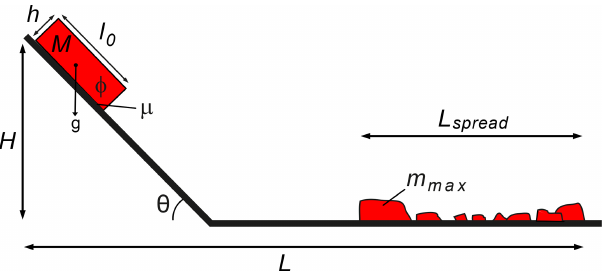
Figure 1. Sketch of the slope geometry of experiments, relevant pa- rameters, and length scales (modified following Haug et al.,